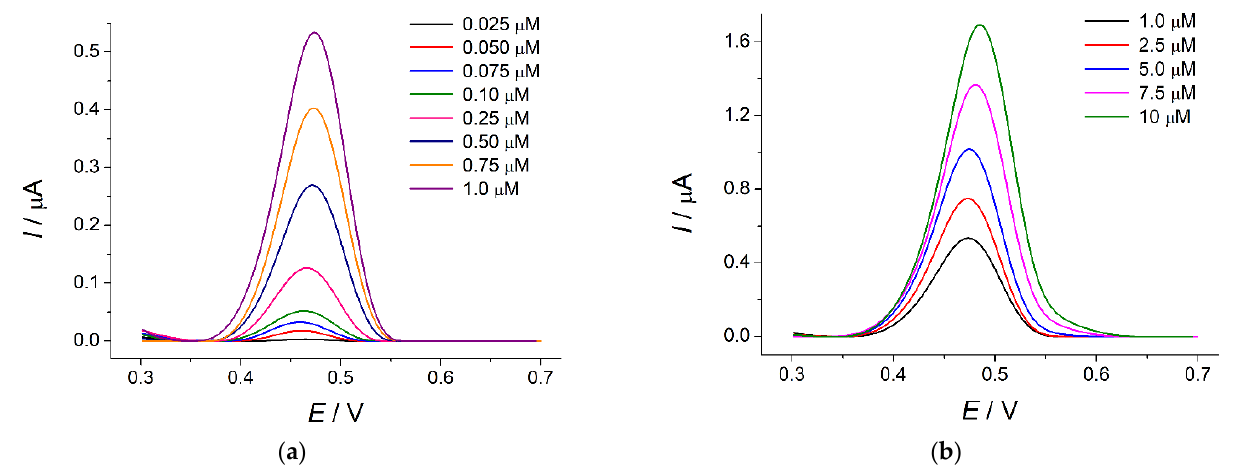
Figure 9. Effect of pulse parameters on the voltammetric characteristics of 50 µM indigo carmine at the SeO 2 –CPB/GCE in phosphate buffer pH 5.0: ( a ) the changes of the oxidation potential; ( b ) the changes of the oxidation currents. Under these conditions, the sensor gives well-resolved response to indigo carmine at 0.47 V (Figure 10).